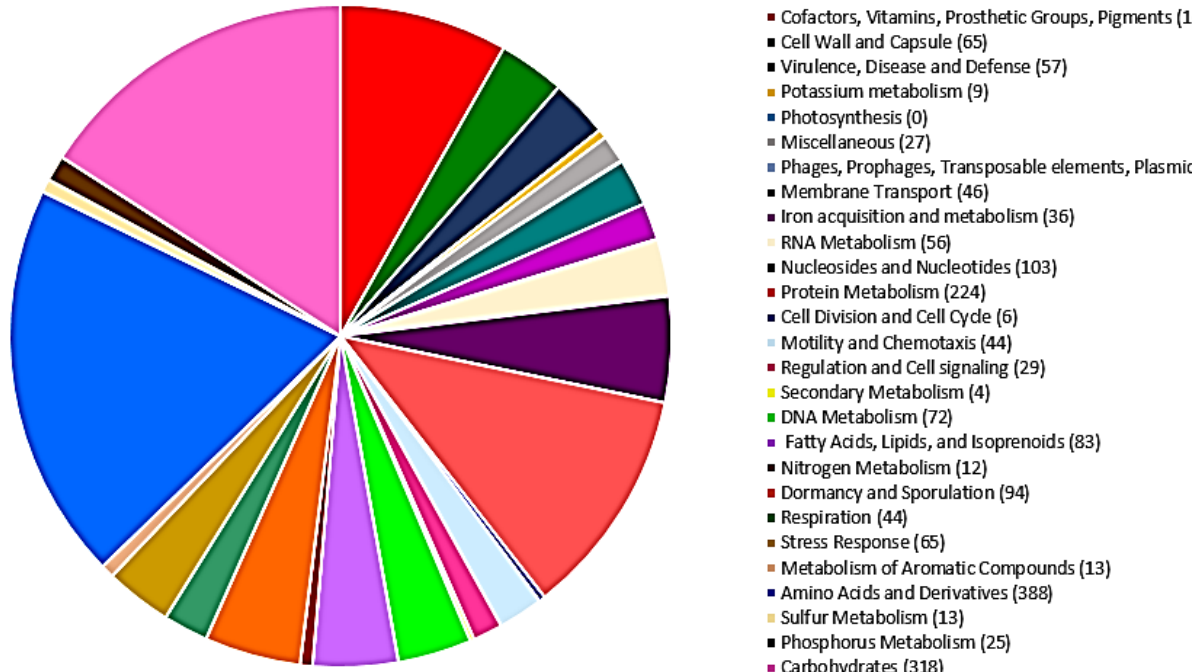
Figure 2. Pie chart of the subsystem category distribution of CDS from Priestia sp. TSO9 was constructed by RAST server version 2.0. CDS: 5623; CDS in subsystems: 1981; and subsystems: 332.